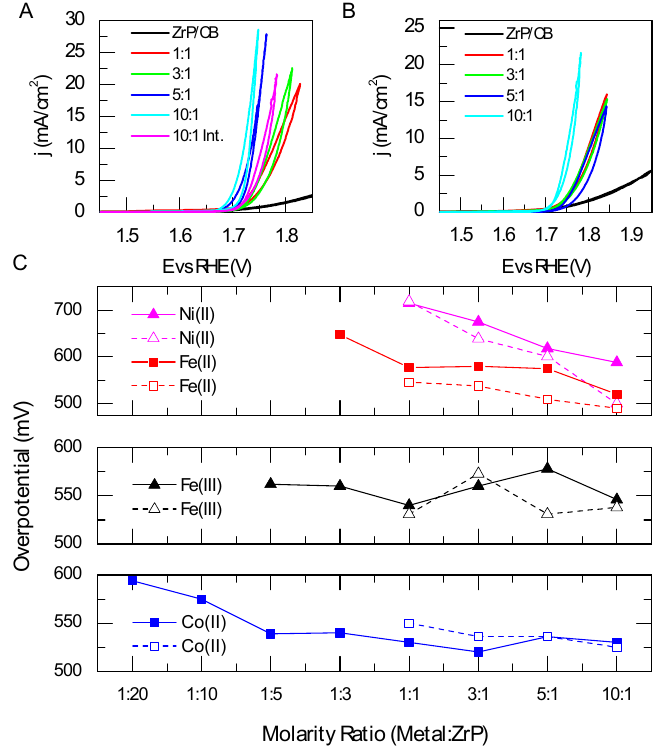
Figure 7. ( A ) Cyclic voltammograms of adsorbed Fe ‐ ZrP. The best CV for intercalated Fe(II) ‐ ZrP is shown in pink. ( B ) Cyclic voltammograms of intercalated Fe ‐ ZrP. ( C ) Electrochemical performance comparison of all four metal systems for adsorbed and intercalated species at 10 mA/cm 2 , except for Ni(II), which was compared at 3 mA/cm 2 . Solid and dashed lines represent intercalated and adsorbed metal ZrP systems, respectively